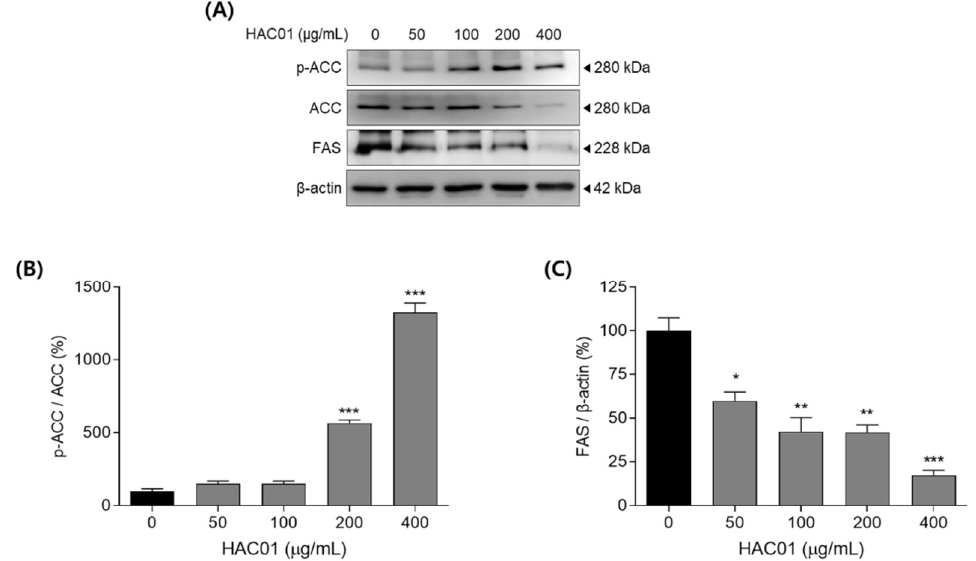
Figure 3. Effects of Lactobacillus plantarum HAC01 lysate on the protein expression levels of lipogenic factors in 3T3-L1 cells. Adipocyte differentiation was induced in the presence of L. plantarum HAC01 lysate for 7 d. ( A ) Western blot band images of lipogenic factors. Representative bands from tripli- cate experiments are shown. ( B , C ) Relative protein expression levels of ( B ) p-ACC/ACC and ( C ) FAS/β-actin. ACC, acetyl-CoA carboxylase; FAS, fatty acid synthase. All results are presented as mean ± SD. * p < 0.01, ** p < 0.005, and *** p < 0.001 vs. 0 μg/mL.